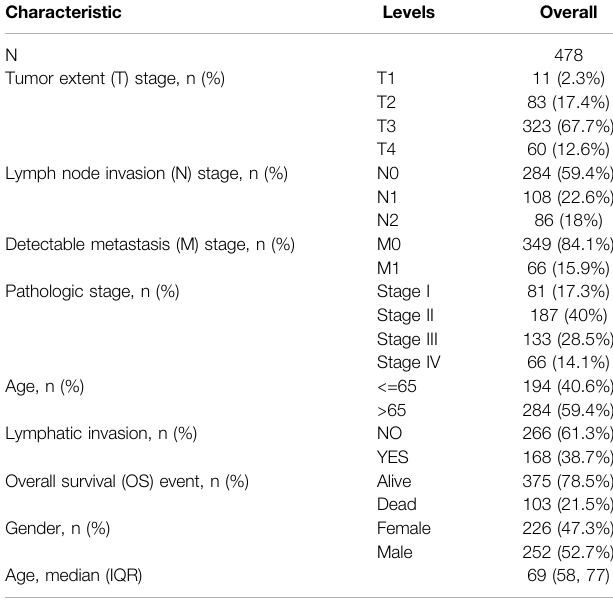
TABLE 1 | Clinical characteristics of the COAD